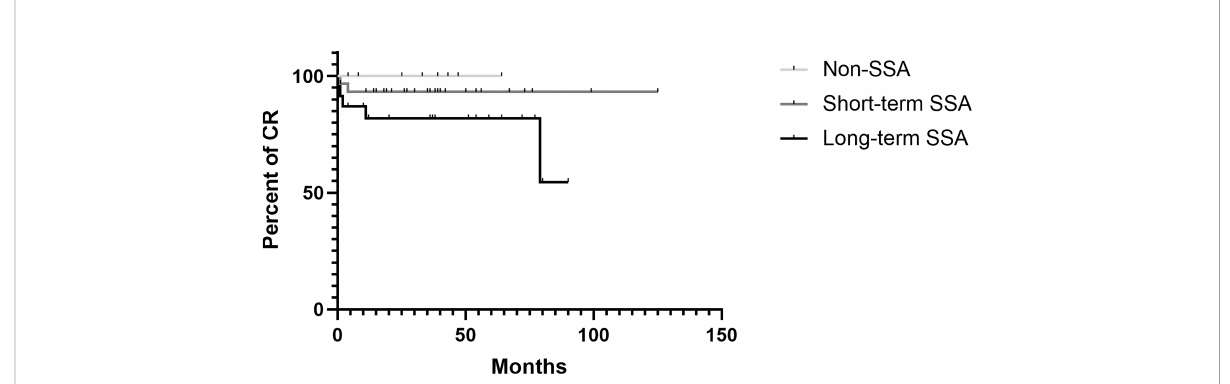
FIGURE 3 Kaplan Meier estimate illustrating the Cumulative complete remission in the population strati fi ed according to presurgical SSA therapy